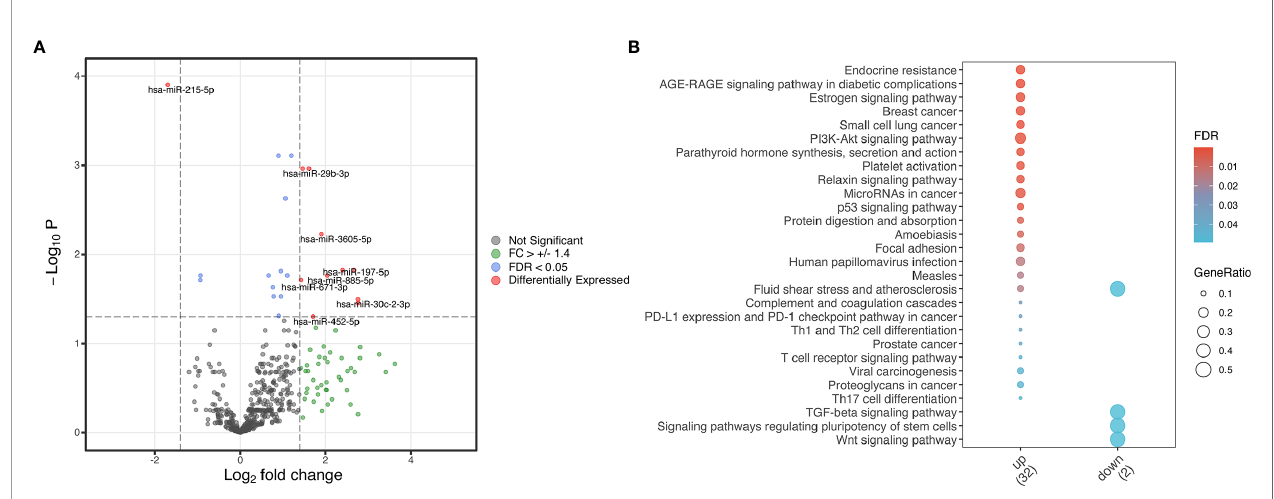
FIGURE 1 | Differentially expressed miRNA in cases versus controls. (A) Volcano plot from differentially expressed miRNA identi fi ed in cases versus controls based on adjusted p-value and log fold-change of miRNA expression. Red indicates differentially expressed miRNA with both a log fold change (FC) higher than 1.4 or lower than -1.4 and a false discovery ratio (FDR) of lower than 0.05. Green indicates miRNA with a log fold change higher than 1.4 or lower than -1.4, and blue indicates miRNA with a false discovery ratio lower than 0.05. Grey indicates genes without a signi fi cant FC or FDR. (B) Enrichment analysis plots from differentially expressed genes. The dot sizes represent the gene ratio in the pathway while the fi ll colors are the FDR values. Only statistically signi fi cant enriched pathways are